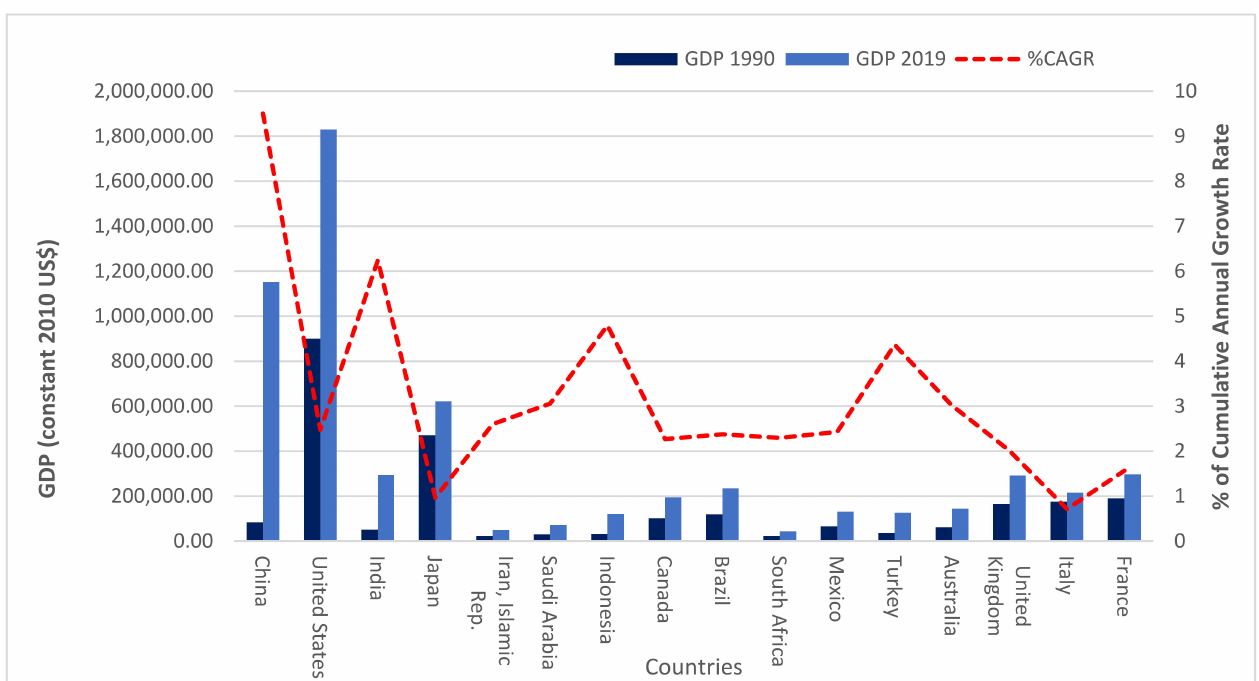
Figure 2. The GDP figures and its growth for the selected